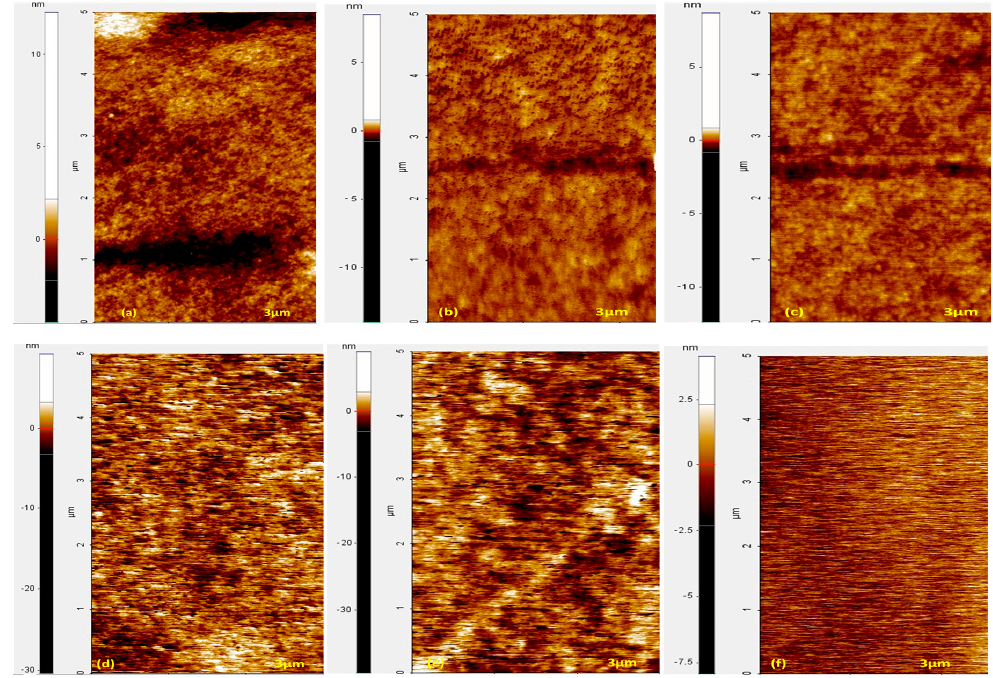
Figure 5. AFM images of PTB7 samples prepared from different solvents with and without DIO: ( a ) CB; ( b ) DCB; ( c ) TCB; ( d ) CB-DIO; ( e ) DCB-DIO; ( f ) TCB-DIO.